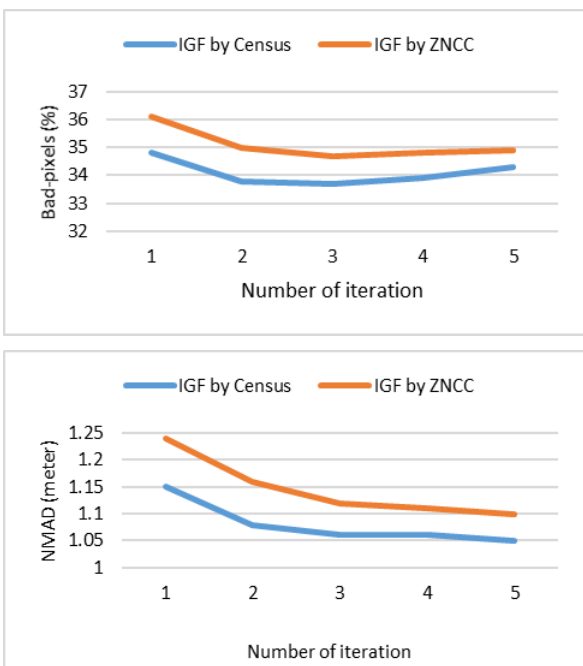
Figure 4. Evaluation of IGF method with different iteration Another parameter which should be tuned is the number of iterations in IGF method. We evaluated the IGF method in 5 iterations as shown in Figure 4. The NMAD and Bad-pixels are computed according to the ground truth and this evaluation shows that the IGF does not improve the GF significantly. However, we selected the result of the IGF method with 3 iterations for further comparison.